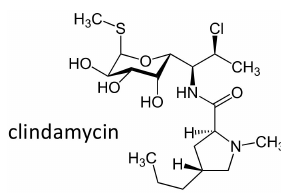
Figure 12. Chemical structure of